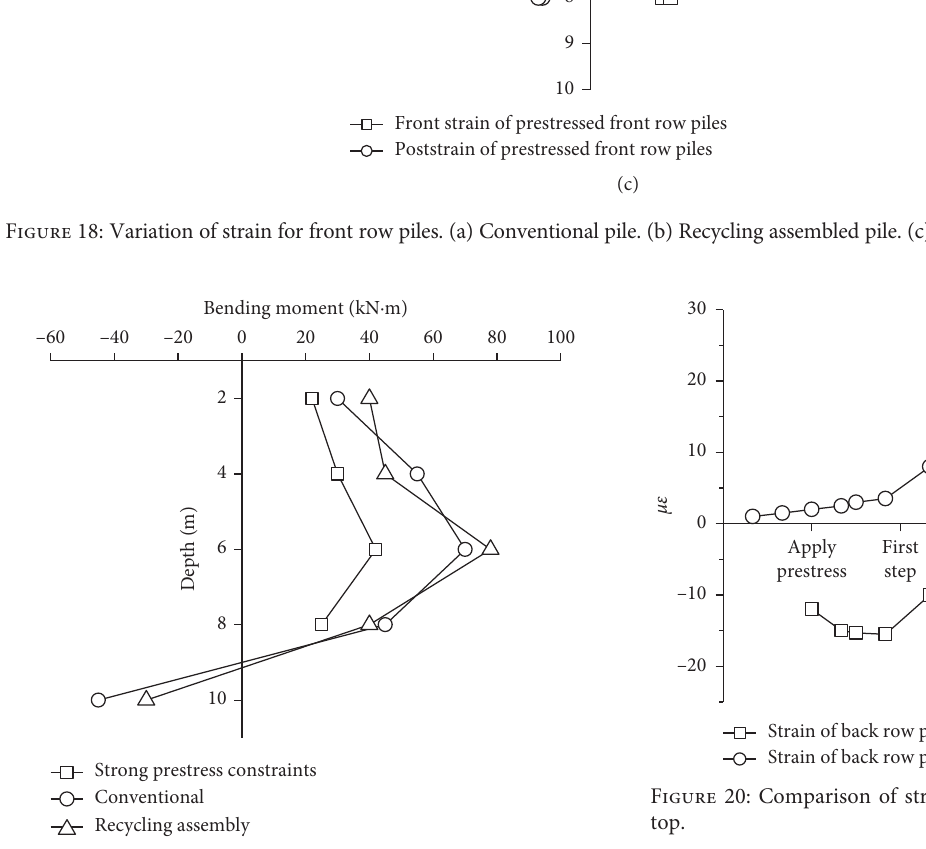
Figure 19: Comparison curve of bending moment.